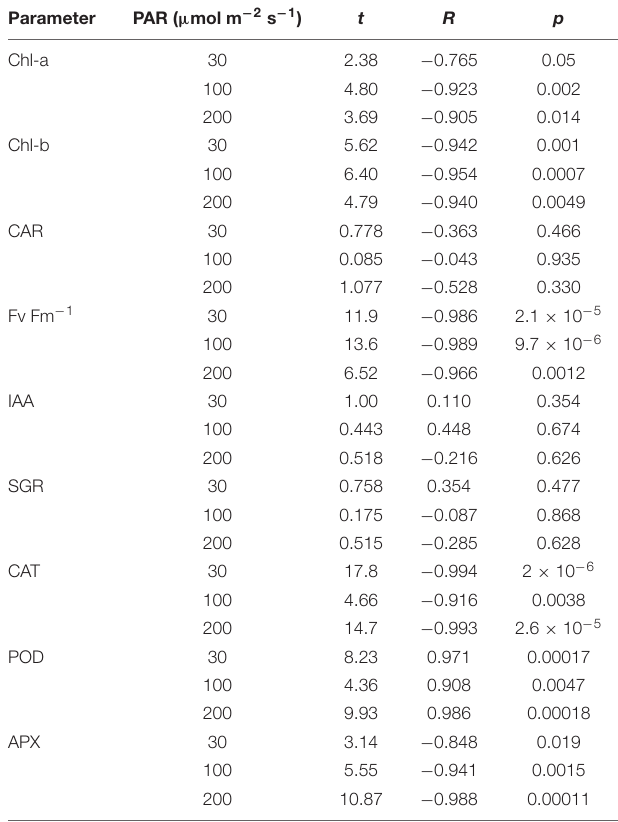
TABLE 2 | Relationship between H 2 O 2 concentration and parameters for different light intensities.